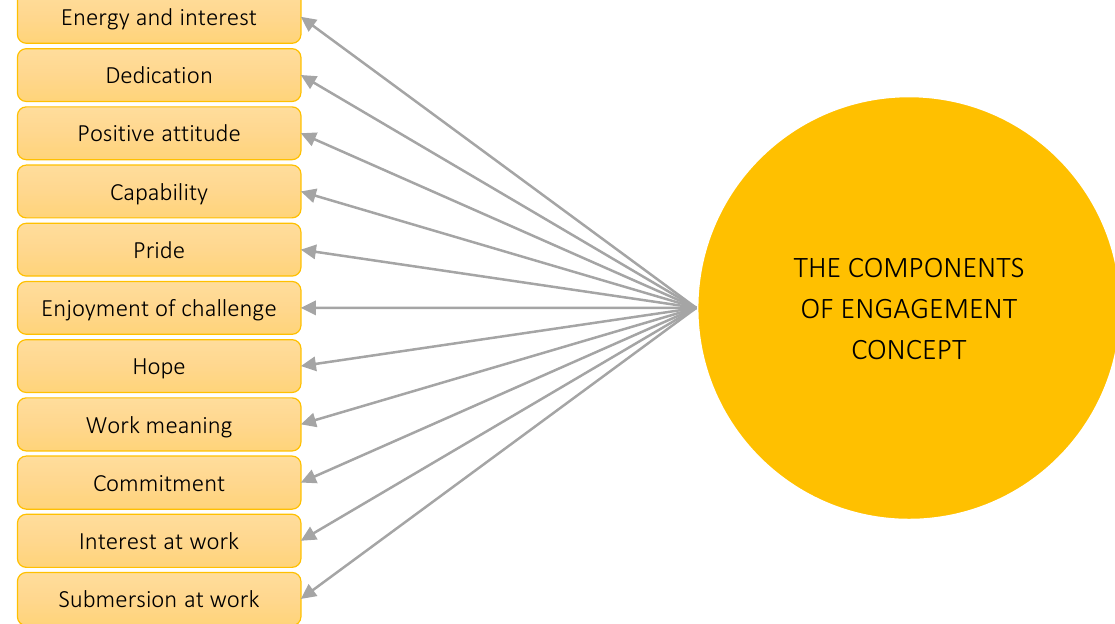
Figure 2. The components of work engagement